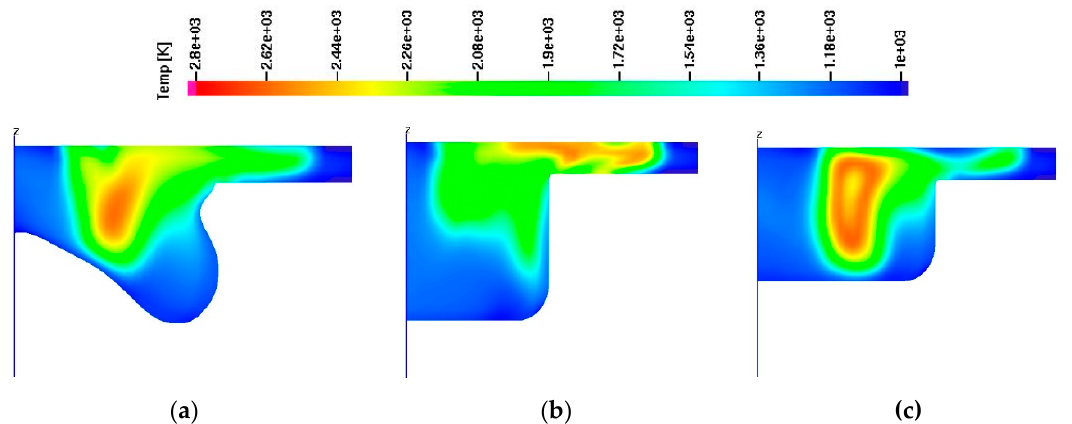
Figure 13. Temperature distribution at PL in the following configurations: STD ( a ), 23R5 ( b ) and 28R5 ( c ) .